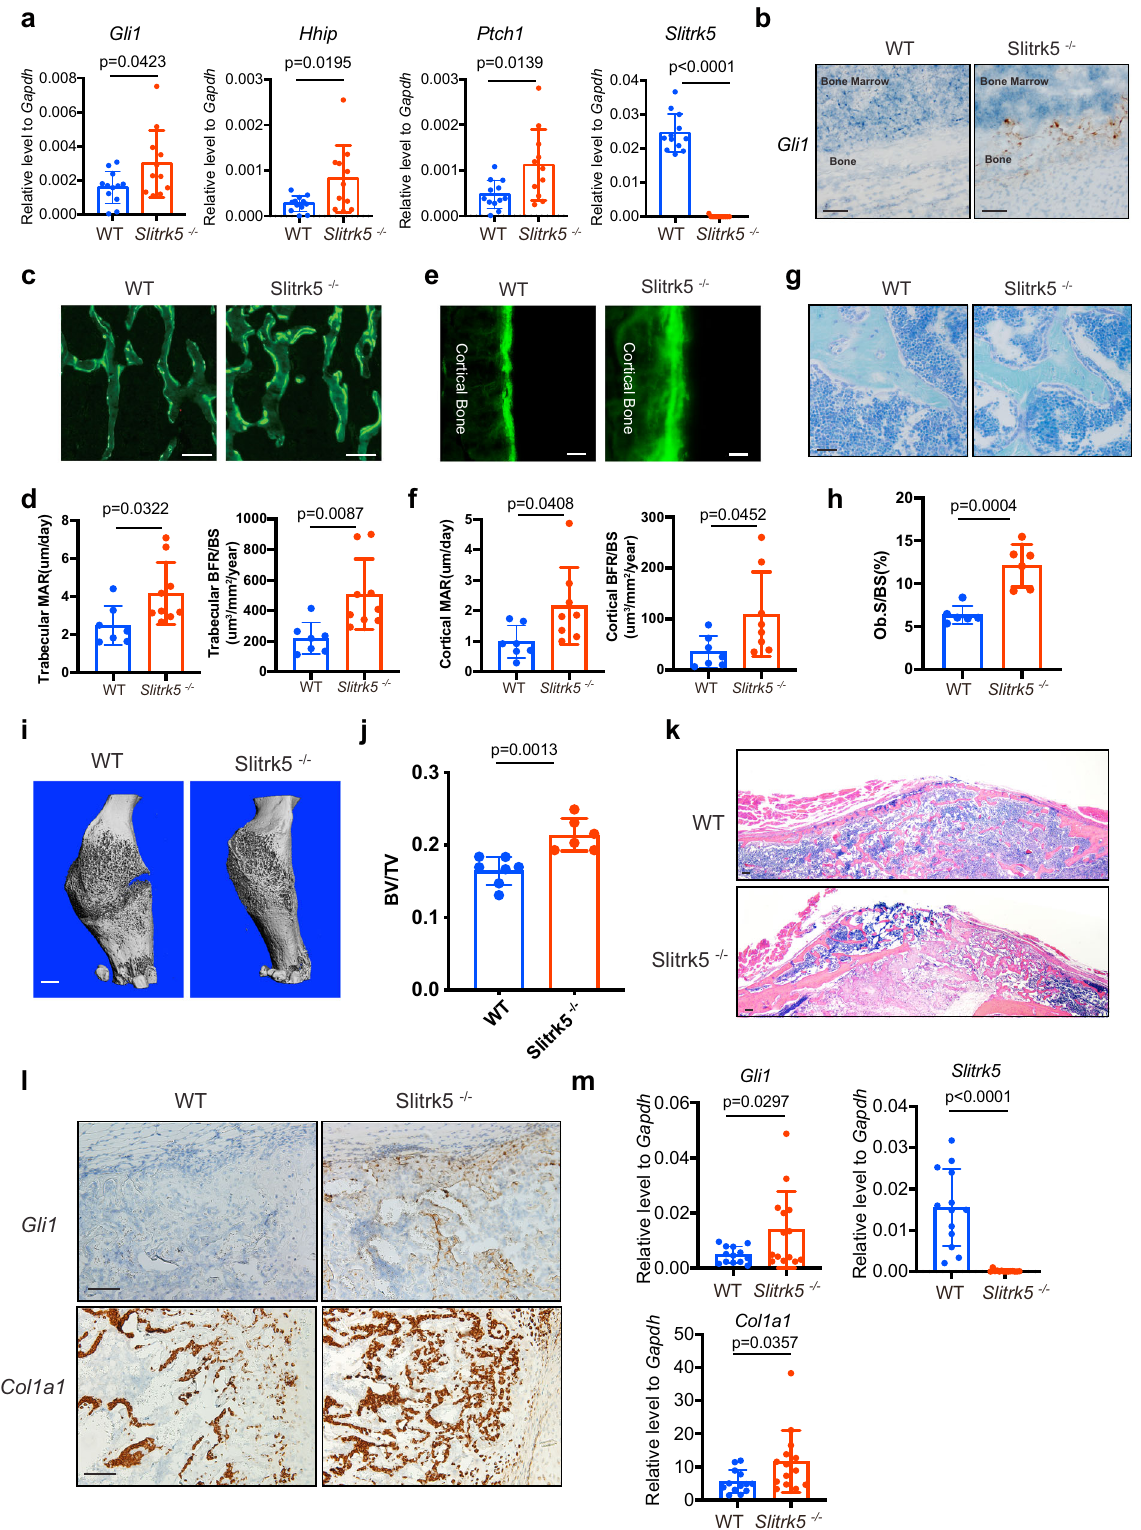
Slitrk5 − / − mice as indicated by the upregulation of Gli1 expression (Fig. 5l, m). Taken together, loss of Slitrk5 led to increased bone formation in both physiological conditions and enhanced fracture healing, phenotypes consistent with biochem- ical observations that SLITRK5 is a negative regulatory co- receptor in the Hh pathway in osteoblasts. responsiveness to Hh ligands is thus tightly controlled by